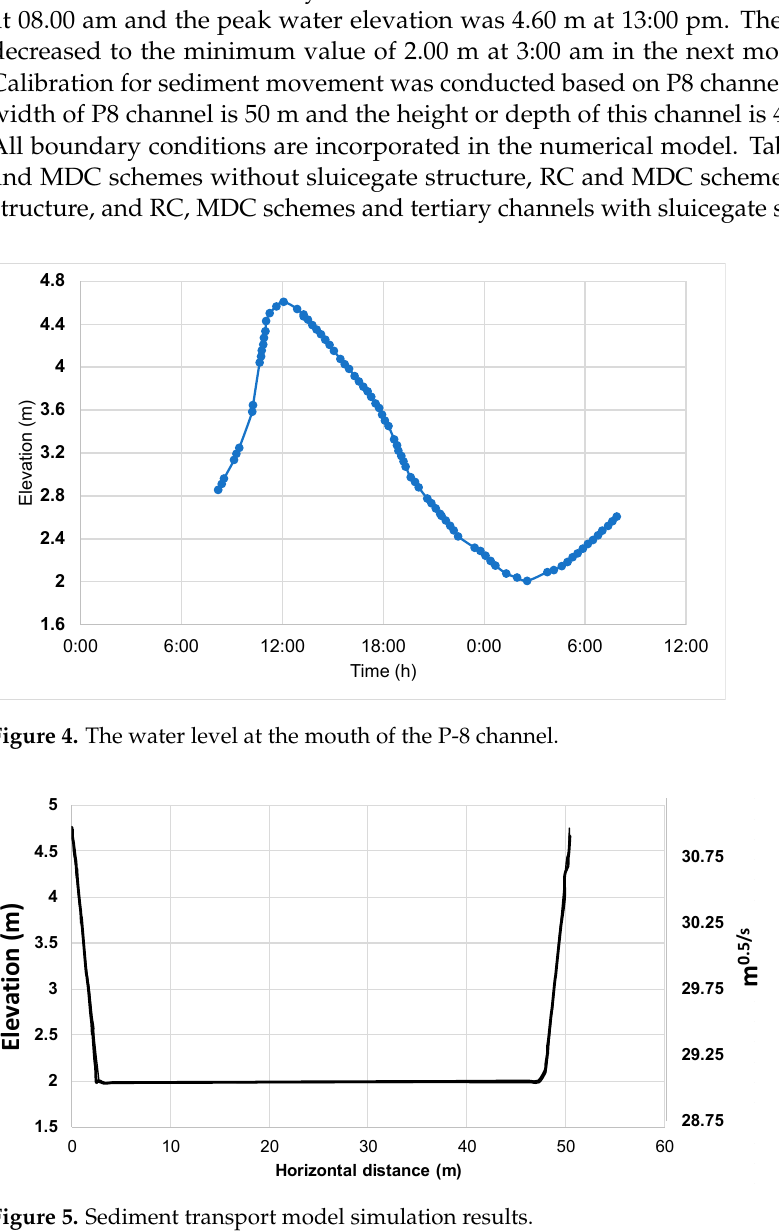
Figure 3. Water level elevation in the Rural Channel .